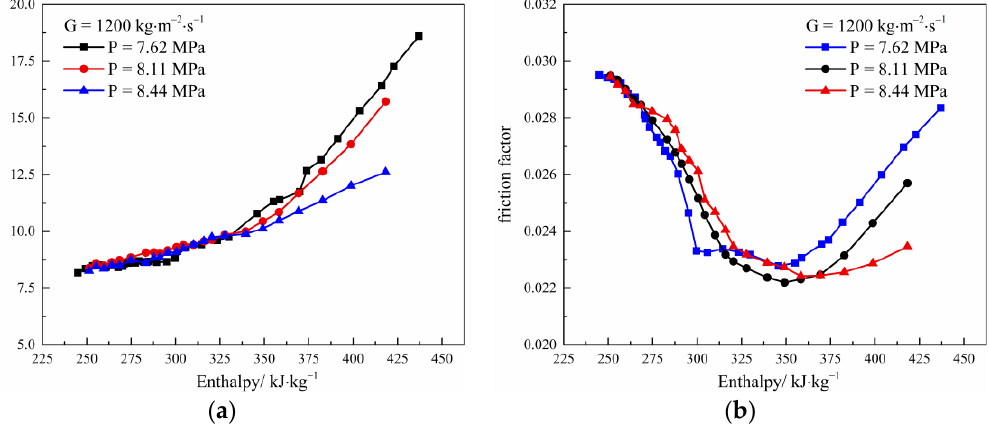
Figure 8. Variation of frictional pressure drop ( a ) and friction factor ( b ) with enthalpy under different pressures.